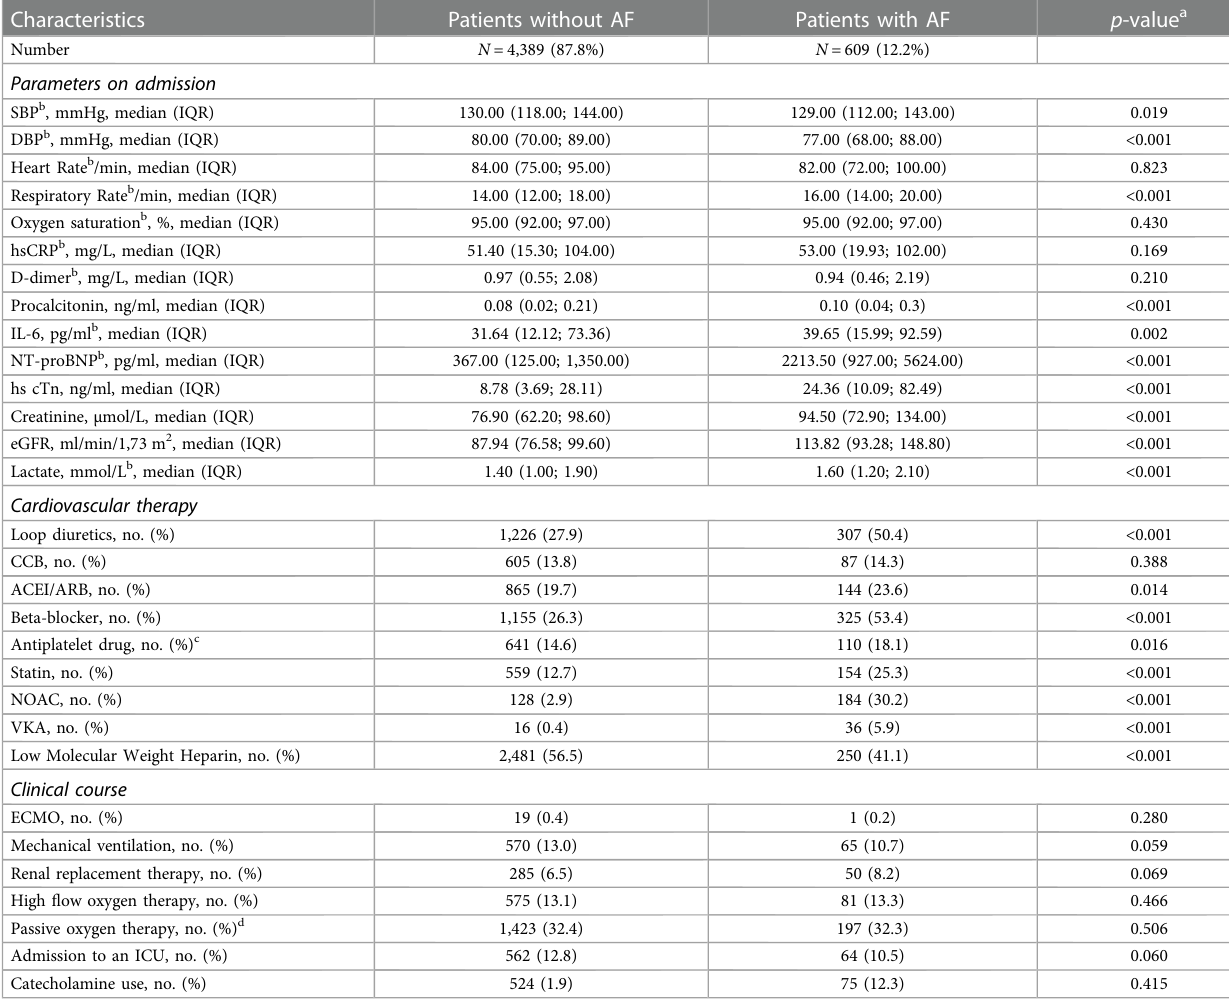
TABLE 2 Clinical characteristics and drug therapy among patients without AF and with AF. Characteristics Patients without AF Patients with AF p -value